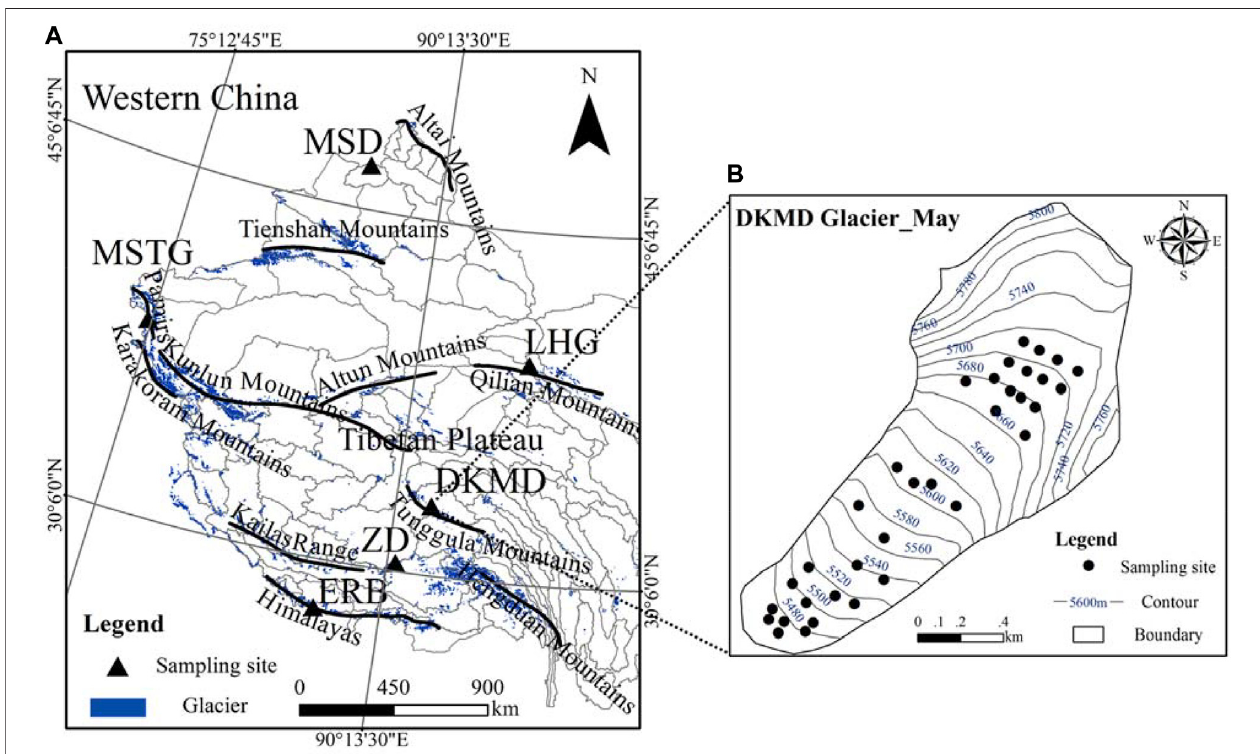
FIGURE 1 | Map showing the location of sampling sites on the glaciers in Western China in this study (A) and the sampling strategy following the contour line on DongkemadiGlacier(DKMD) ineach month from MaytoOctober 2015 (B) .Theglaciers ofsnow sampling including Musidao Glacier (MSD), Muztagata Glacier(MSTG), Laohugou No. 12 Glacier (LHG), DKMD, Zadang Glacier (ZD), and East Rongbuk Glacier (ERB) are shown. The map also shows glaciers and mountains in Western China, and the glacier data were adopted from the Second Chinese Glacier Inventory (Guo et al., 2015).